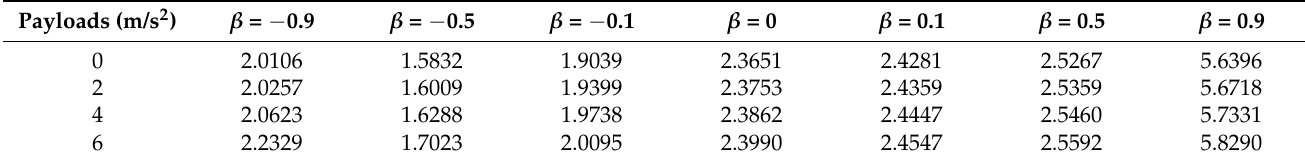
Table 5. Root mean squared value of the control signal u 2 in the first 30 s under different payloads and different fractional orders in the proposed controller.